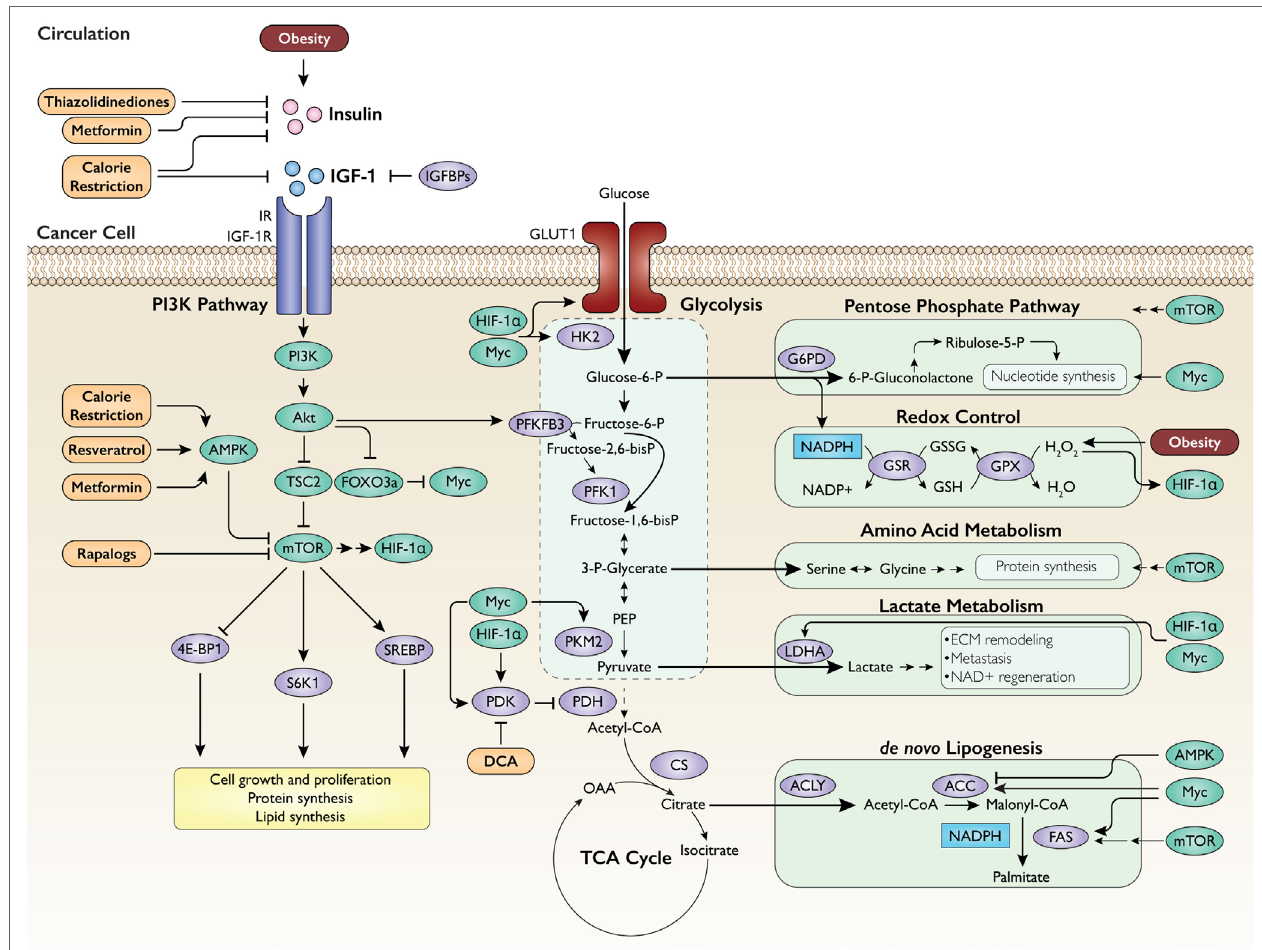
FiGURe 1 | Regulation of intrinsic cancer metabolism by obesity-associated growth factors. Insulin and insulin-like growth factor 1 (IGF-1) activate the phosphatidylinositol 3-kinase (PI3K) pathway, which in turn upregulates glycolysis and subsidiary metabolic pathways to generate energy and fulfill the biosynthetic needs of proliferation. IGFBPs, IGF-binding proteins; IR, insulin receptor; IGF-1R, IGF-1 receptor; AMPK, AMP-activated protein kinase; TSC2, tuberous sclerosis 2; FOXO3a, forkhead box O3a; Myc, c-Myc; mTOR, mammalian target of rapamycin; HIF-1 α , hypoxia-inducible factor 1-alpha; 4E-BP1, eukaryotic translation initiation factor 4E-binding protein 1; S6K1, ribosomal protein S6 kinase beta-1; SREBP, sterol regulatory element-binding protein; HK2, hexokinase 2; PFKFB3, 6-phosphofructo-2-kinase/fructose-2,6-bisphosphatase 3; PFK1, phosphofructokinase-1; PEP, phosphoenolpyruvate; PKM2, pyruvate kinase M2; PDK, pyruvate dehydrogenase kinase; PDH, pyruvate dehydrogenase; CS, citrate synthase; OAA, oxaloacetate; G6PD, glucose-6-phosphate dehydrogenase; GSR, glutathione reductase; GSX, glutathione peroxidase; LDHA, lactate dehydrogenase A; ECM, extracellular matrix; ACLY, ATP citrate lyase; ACC, acetyl-CoA carboxylase; FAS, fatty acid synthase; DCA, dichloroacetate. Intervention approaches are shown in